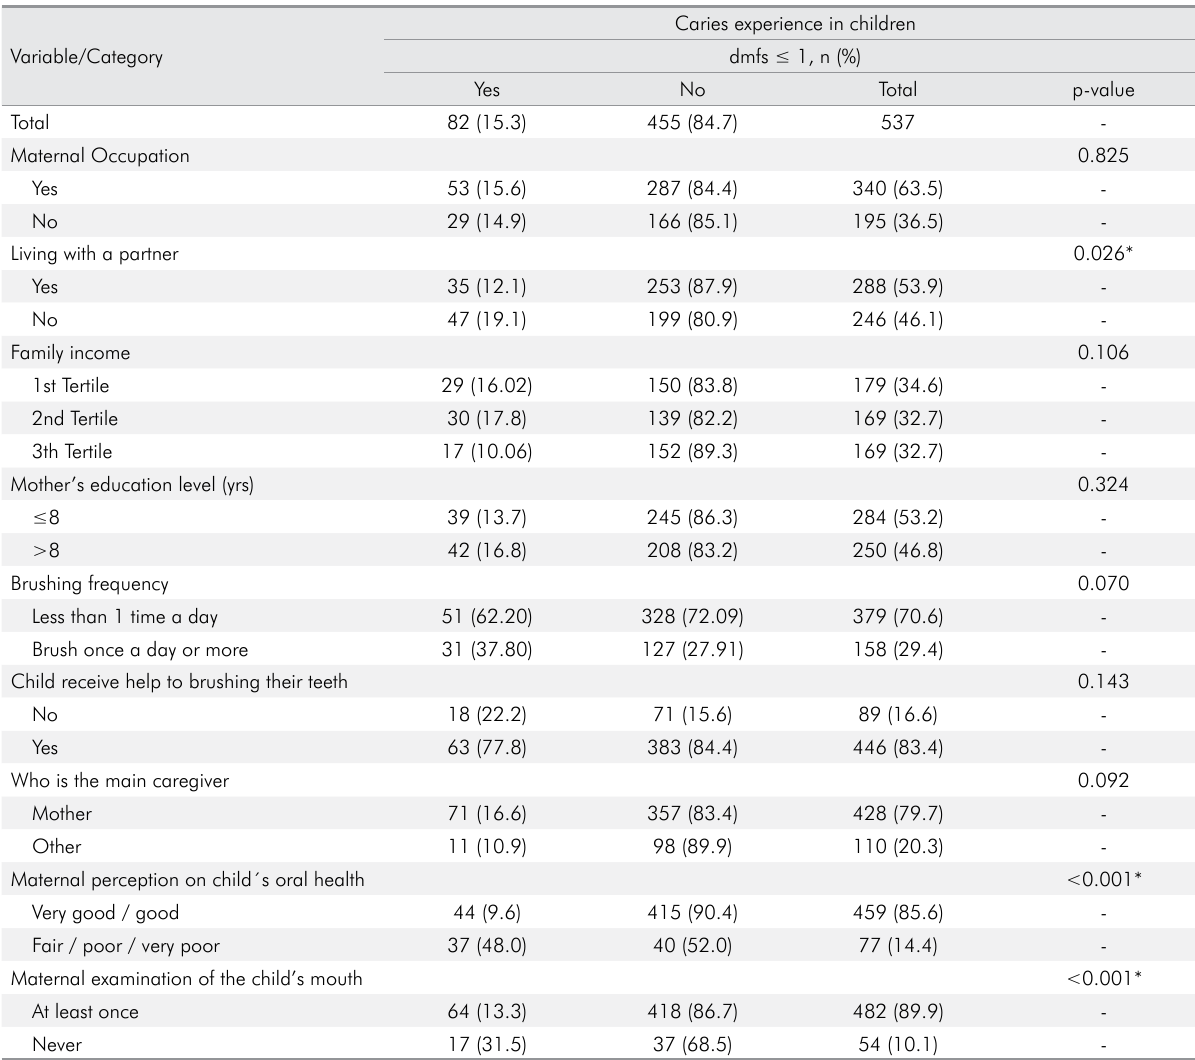
Table 1. Association between caries experience in childhood and maternal socioeconomic and demographic characteristics, hygiene and care of mother in a sample adolescents in the city Pelotas, RS, Brazil, 2015.